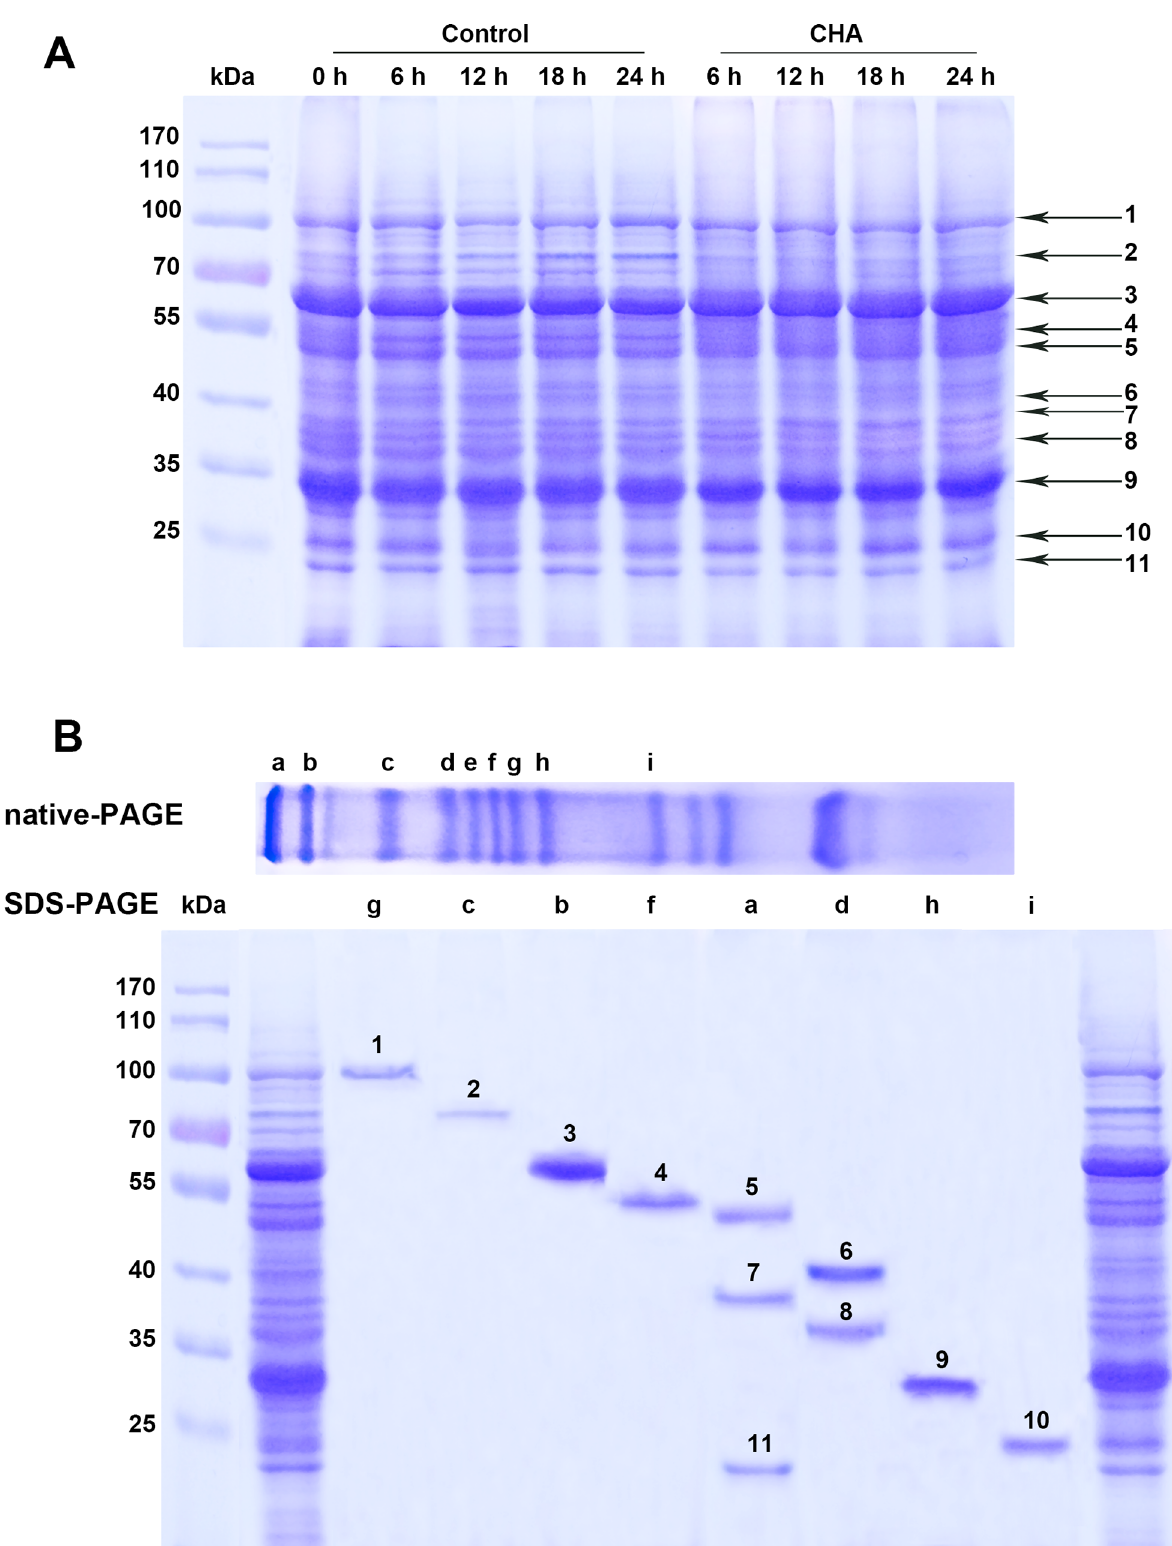
Fig 3. Identification of proteins related to senescence of apple pulp disc. (A) SDS-PAGE analysis of protein profile of apple pulp discs during incubation at 25°C; (B) Identifying and isolation of proteins (band 1 – 11) related to senescence of apple pulp discs by native-PAGE and SDS – PAGE. doi:10.1371/journal.pone.0146940.g003 PLOS ONE | DOI:10.1371/journal.pone.0146940 January 12,